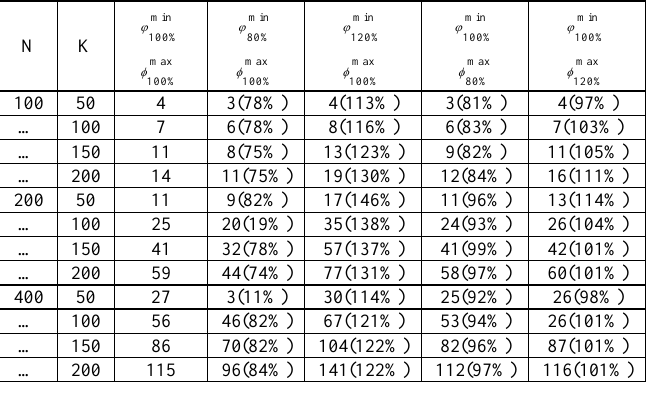
Fig. 3. Operation effect of the